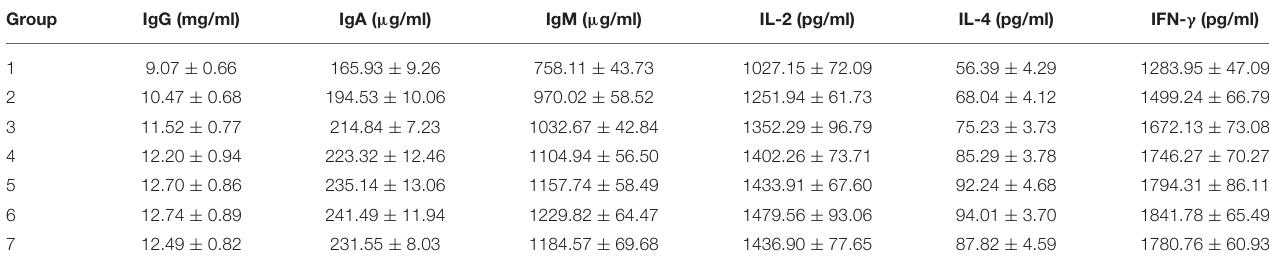
TABLE 3 | The contents of tested immunoglobulin M (IgM), immunoglobulin G (IgG), immunoglobulin A (IgA), interleukin (IL)-2, IL-4, and I interferon- γ (FN- γ ) in groups 1–7 at fourth week (Mean ± SE, n = 8).